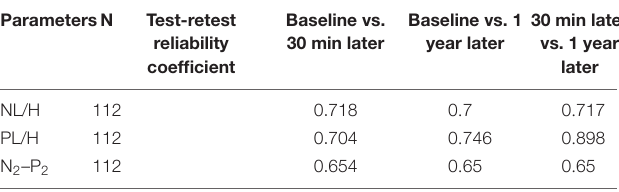
TABLE 6 | Test-retest reliability of contact heat evoked potential parameters for the right forearm at different time points.